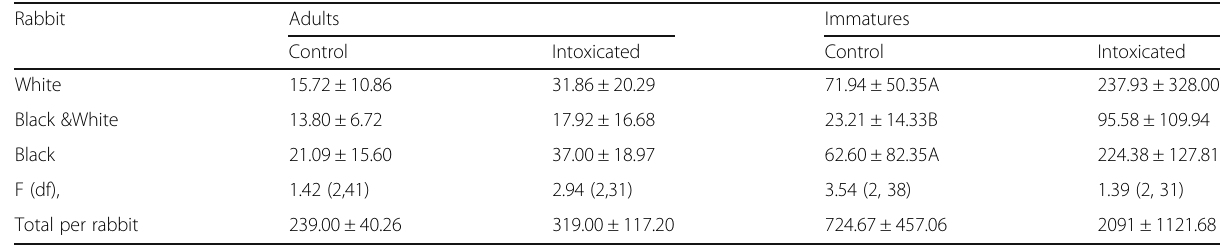
Table 2 Means ± SDs of daily and total collections of dipteran adults and immatures on control and warfarin-intoxicated carcasses